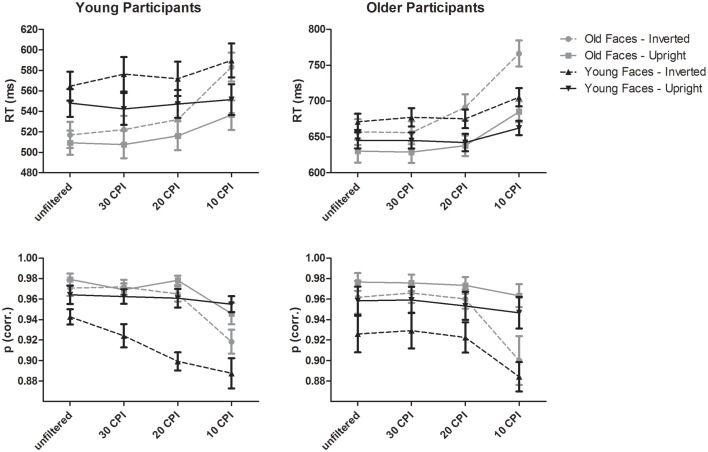
Behavioral data from young and older participants. Error bars depict standard errors of the mean.